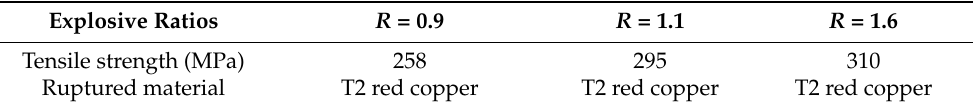
Table 4. Test results of tensile shear of T2 red copper/HNASS under different explosive welding